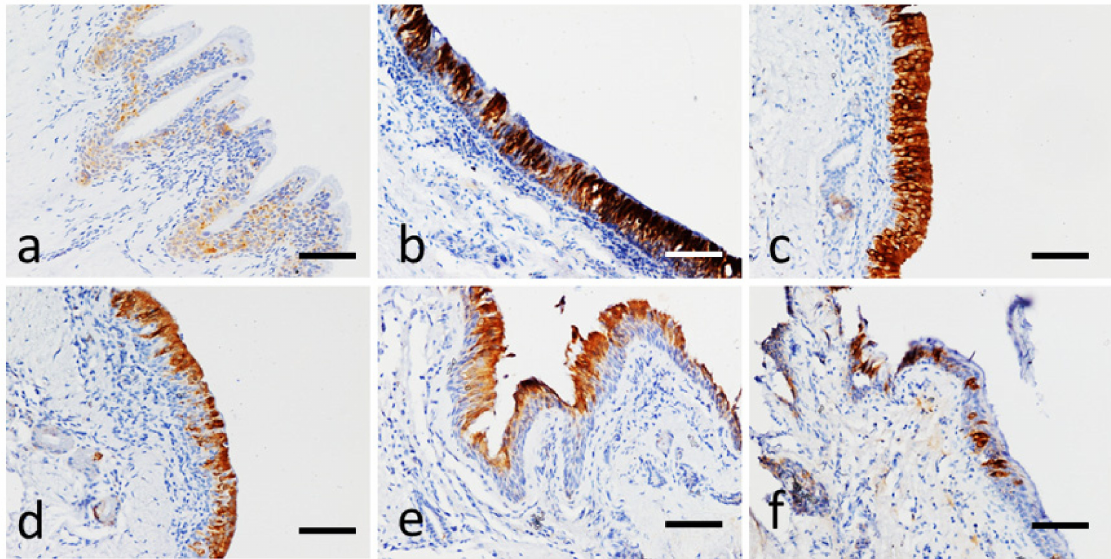
Figure 5. IL-8 immunohistochemical stain (brown color), bar 200 µ m. ( a ) Bronchial mucosa of a control horse. Focal and weak cytoplasmic positivity to the respiratory epithelium. ( b ) EA-case 2, distal right bronchus, T3. Strong and diffuse positivity to the epithelial cells of the mucosa. ( c ) EA-case 2, proximal right bronchus, T3. Note the intense immunopositivity in all layers of the hyperplastic mucosa. ( d ) EA-case 2, distal right bronchus, T2. Note the distribution of positivity in the most superficial layers of the mucosa. ( e ) EA-affected horse 6, proximal left bronchus, T3. The positivity appears to be confined to the most superficial layer of the epithelium also in this case. ( f ) EA-case 5, proximal left bronchus, T1. Focal positivity confined to isolated respiratory epithelial